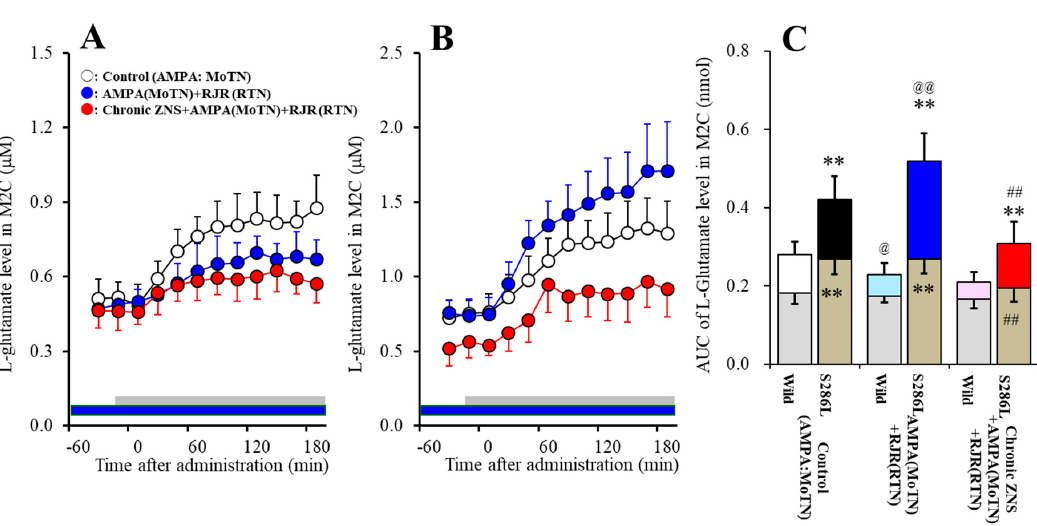
Figure 5. Effects of local administration of RJR2403 ( α 4 β 2-nAChR agonist) into the reticular thalamic nucleus (RTN) and subchronic administration of therapeutic-relevant dose of ZNS (40 mg/kg/day for 7 days) on the L-glutamate release in the secondary motor cortex (M2C) induced by local administration of 100 µ M amino-3-(3-hydroxy-5-methyl-isoxazol-4-yl)propanoic acid (AMPA) into the motor thalamic nuclei (MoTN) of wild-type ( A ) and S286L-TG ( B ). Rats were subchronically administered a therapeutic-relevant dose of ZNS (chronic ZNS) or ZNS-free (control or AMPA + RJR) using a subcutaneous osmotic pump. In ZNS non-treated rats, perfusion medium in the RTN was commenced with modified Ringer’s solution (MRS) with (AMPA + RJR: blue circles) or without (control: opened circles) 100 µ M RJR2403 (blue bars). After the stabilization of L-glutamate levels in the M2C, the perfusion medium in the MoTN was switched from MRS to MRS containing 100 µ M AMPA for 180 min (gray bars). In ZNS treated rats (chronic ZNS: red circles), perfusion medium in the RTN was commenced with MRS containing 100 µ M RJR2403. After the stabilization of L-glutamate levels in the M2C, the perfusion medium in the MoTN was switched from MRS to MRS containing 100 µ M AMPA for 180 min (gray bars). Ordinates indicate mean extracellular L-glutamate level ( µ M) (N = 6), and abscissas indicate time after AMPA-evoked stimulation (min). Blue bars indicate the perfusion with 100 µ M RJR2403 into the RTN. Gray bars indicate the perfusion with 100 µ M AMPA into the MoTN. ( C ) indicates the area under curve value (AUC) value of extracellular L-glutamate level (nmol) before (basal extracellular L-glutamate level) and during perfusion with AMPA (from 20 to 180 min) of Figure 5A and 5B. Gray columns in Figure 5C indicate the AUC values of basal extracellular levels of L-glutamate in Figure 5A,B (during − 60 to 0 min). ** P < 0.01; relative to wild-type, @P < 0.05, @@P < 0.01; relative to control, ##P < 0.01; relative to AMPA + RJR by multivariate analysis of variance (MANOVA) with Tukey’s post hoc test.